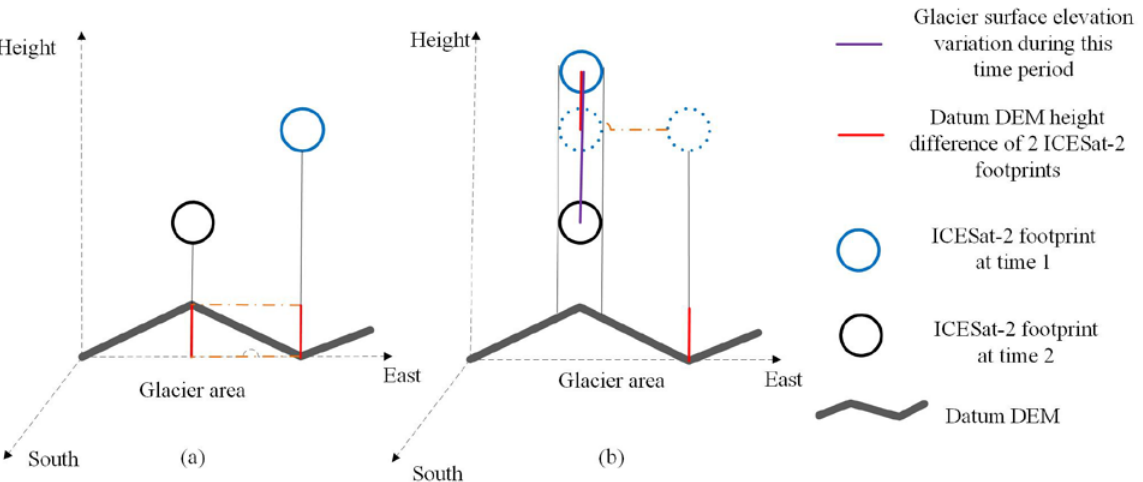
Figure 3. Local-scale calibration processing of glacier surface elevation of two laser footprints. ( a ) The original two ICESat-2 footprints and the yearly datum DEM. ( b ) The two ICESat-2 footprints after the plane position calibration process. after the plane position calibration